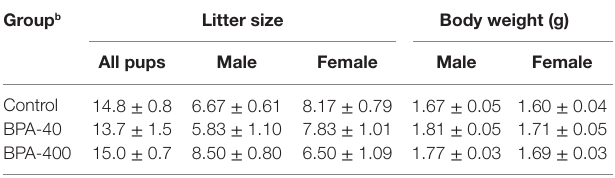
TaBle 1 | litter size and pup body weight after in utero BPa exposure a